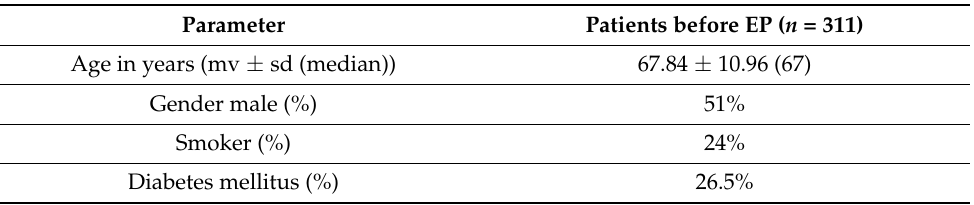
Table 2. Characteristics of patients before endoprosthesis (EP) insertion. Values are given as mean value (mv) ± standard deviation (sd) or as percentage